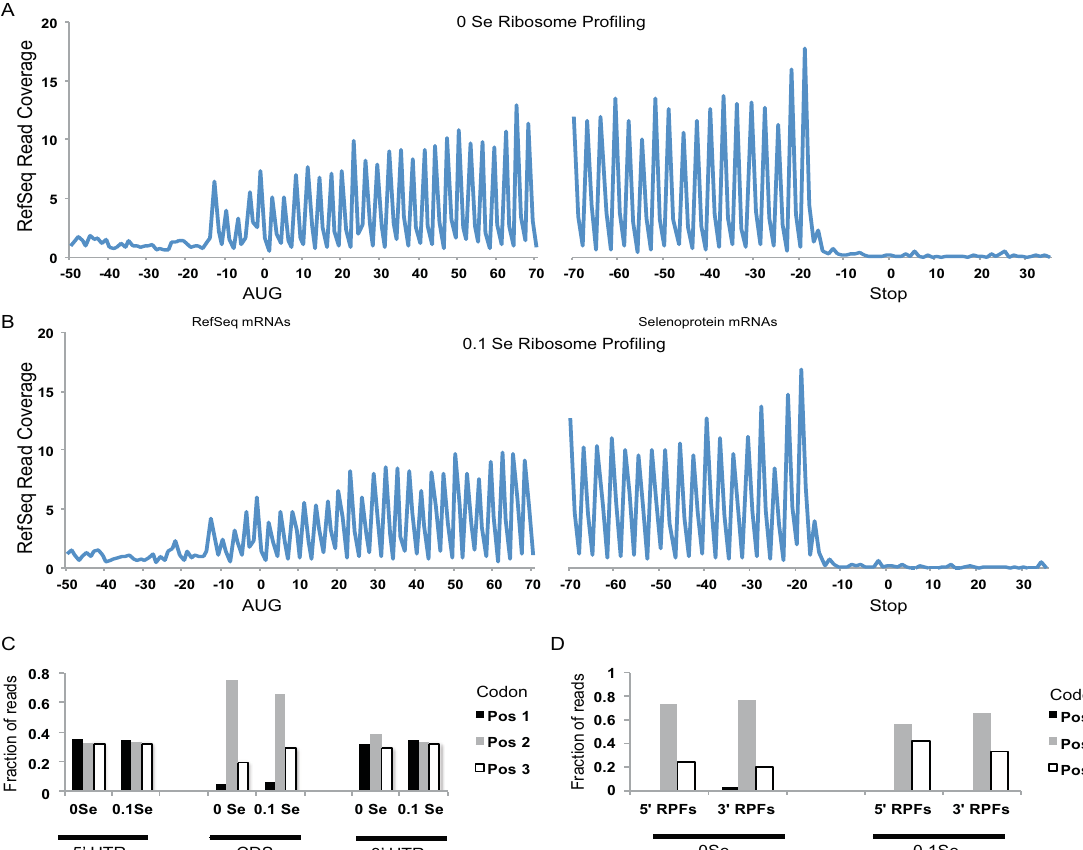
Figure 2. Analyses of ribosome footprint (RPF) distribution on RefSeq and selenoprotein mRNAs. ( A ) 0 ppm Se and ( B ) 0.1 ppm Se samples. RPF 5 1 ends were aligned to all